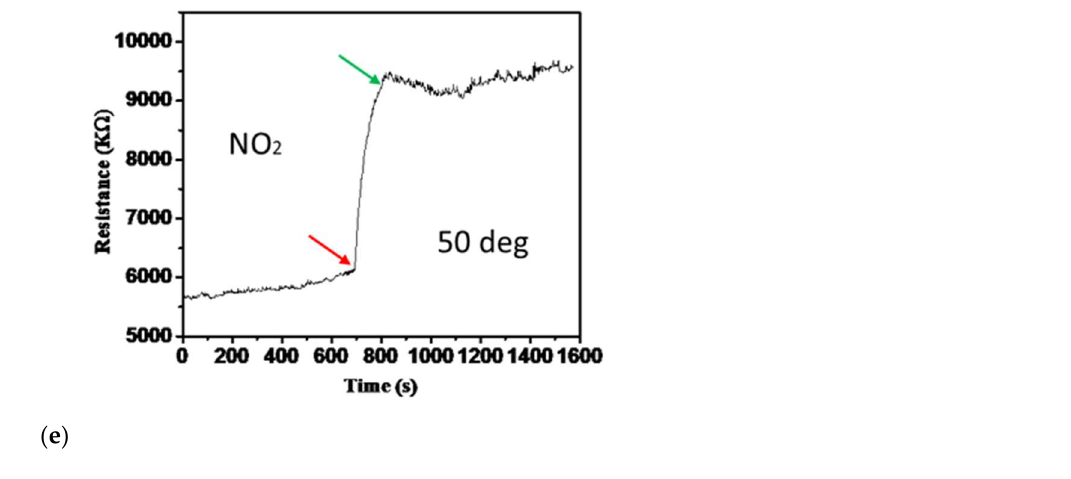
Figure 8. ( a – d ) The sensor performance of 1 ppm of H 2 S, NO, NO 2 , and NH 3 at 150 ◦ C. ( e ) -Sensor response for one ppm of NO 2 at 50 C. Table 2. Comparison table for different gases and materials.